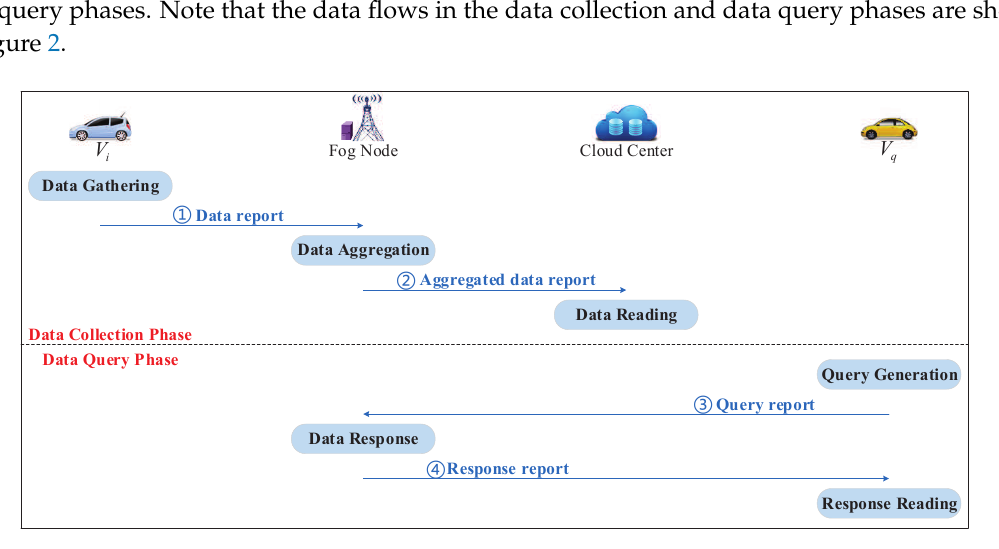
Figure 2. Data flows in the data collection and data query